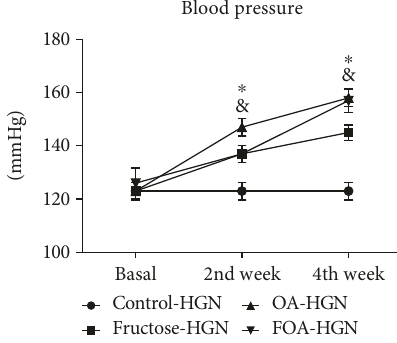
Figure 2: Systolic blood pressure in HGN groups at basal time, 2nd week, and 4th week after beginning of treatment. HGN: hypogonadic; OA: oxonic acid; FOA: fructose and oxonic acid. & p < 0 05 control versus OA group at 2nd week and control versus fructose group at 4th week. ∗ p < 0 001 control versus OA and FOA group at 4th week.